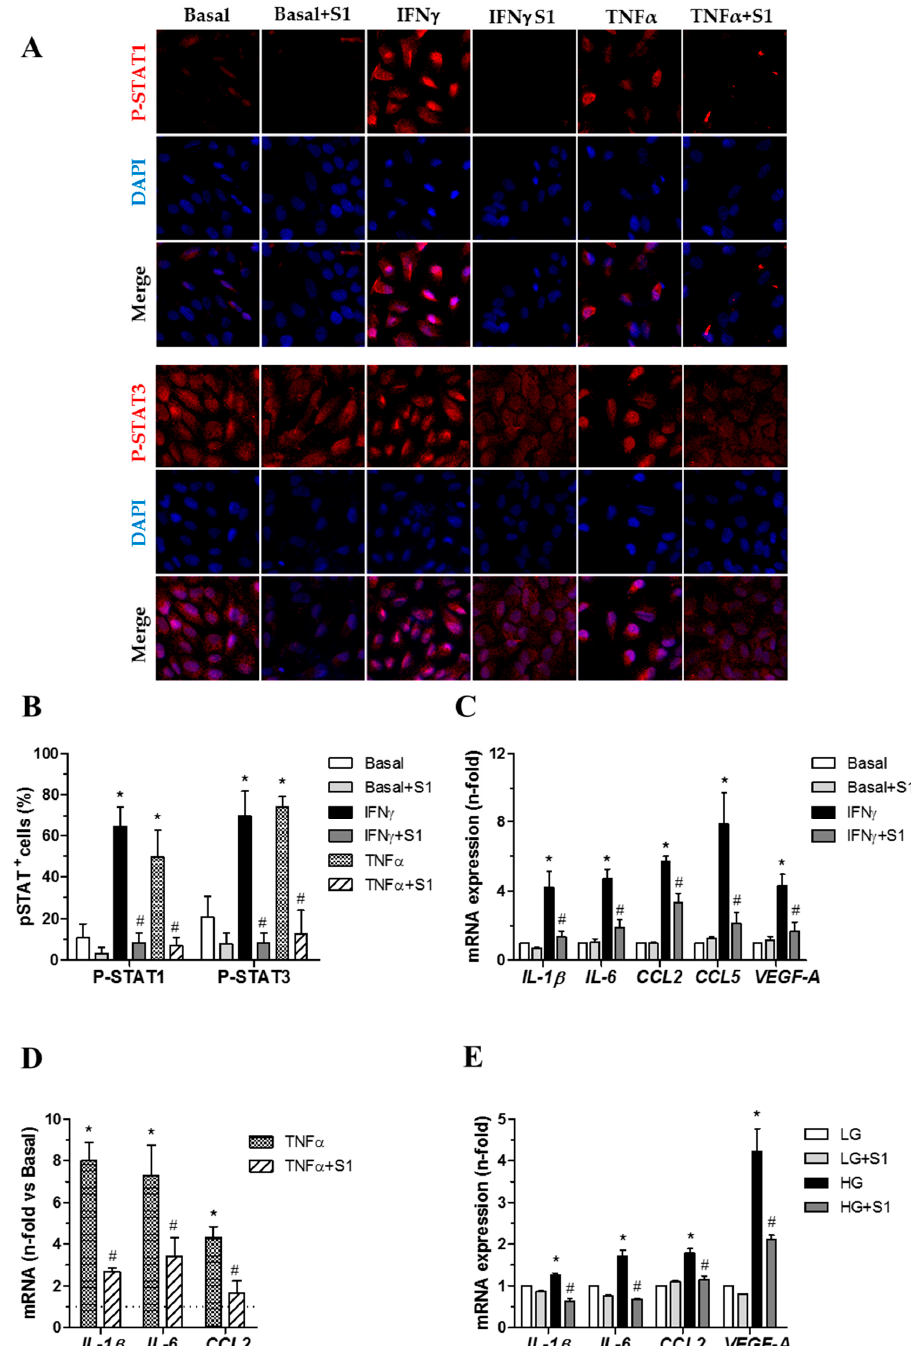
Figure 9. Effects of SOCS1 peptidomimetic peptide in vitro. ( A ) Representative confocal images of p-STAT1 and p-STAT3 localization in ARPE-19 cells under control conditions and after 30 min of stimulation with IFN ϒ (10 ng/mL) and TNF α (10 ng/mL) in the presence or absence of SOCS1 peptidomimetic (S1, 100 µg/mL). ( B ) Quantification of p-STAT-positive cells per total cells (DAPI-positive nuclei). ( C – E ) Real-time PCR analysis of indicated genes in ARPE-19 cells pretreated with SOCS1 peptide and stimulated with IFN ϒ ( C ), TNF α ( D ) and high-glucose (HG; E ). Values normalized by 18S are expressed as fold increases over basal (dashed line in D ) and low-glucose (LG) conditions. Bars represent the mean ± SEM of duplicate determinations from 4 experiments. * p < 0.05 vs. Control, # p < 0.05 vs.